Question: In one sentence, what is this figure communicating?
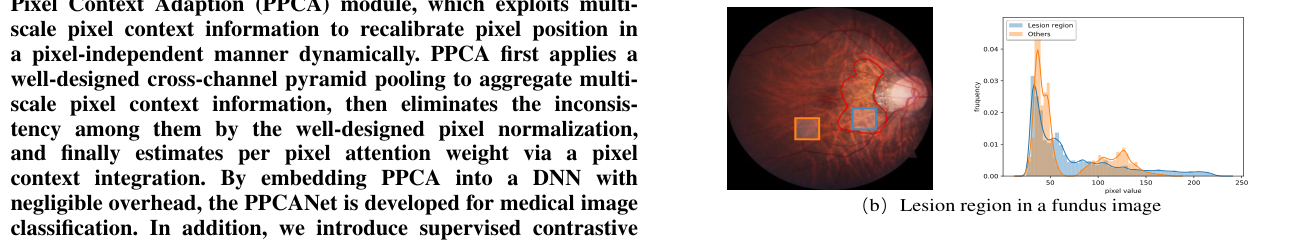
Answer: (a) Object region in a natural image, which is salient through observing pixel value distribution difference between object region and other regions. (b) The subtle lesion region of myopia on the fundus image. We also present a pixel value distribution comparison between a subtle lesion region and a redundant region.